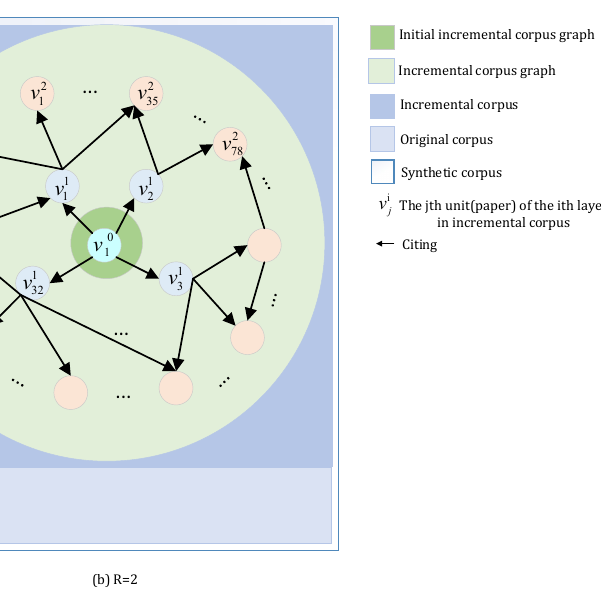
Figure 3. A more complex example of C γ construction using arXiv ID